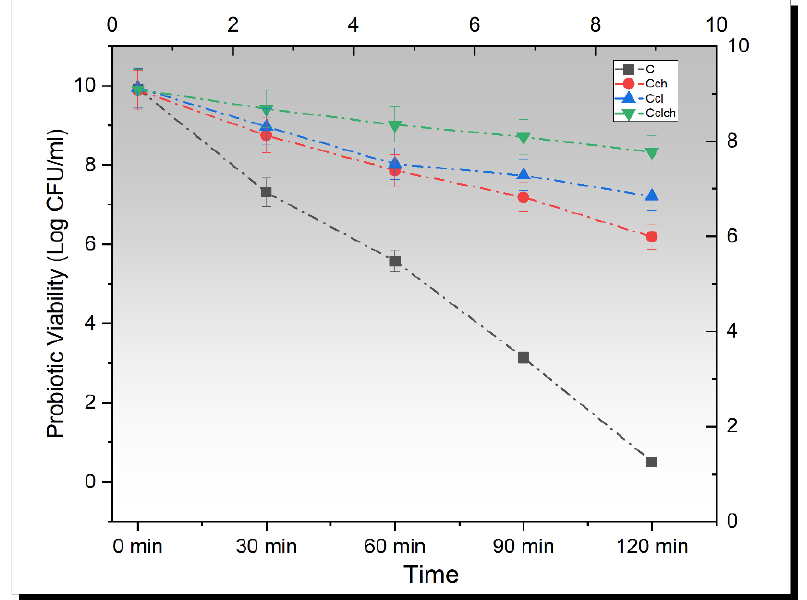
Figure 2. Viability of un-encapsulated and encapsulated (cellulose, chitosan, and cellulose–chitosan hybrid cells) probiotic microgels under simulated gastric fluid conditions during storage intervals (0, 30, 60, 90, and 120 min) compared with control. Each line represents mean value for viability of treatments. C (un-encapsulated probiotics), Cch ( L. plantarum encapsulated with chitosan), Ccl ( L. plantarum encapsulated with cellulose), and Cch-cl ( L. plantarum encapsulated with chitosan and cellulose hybrid cells).